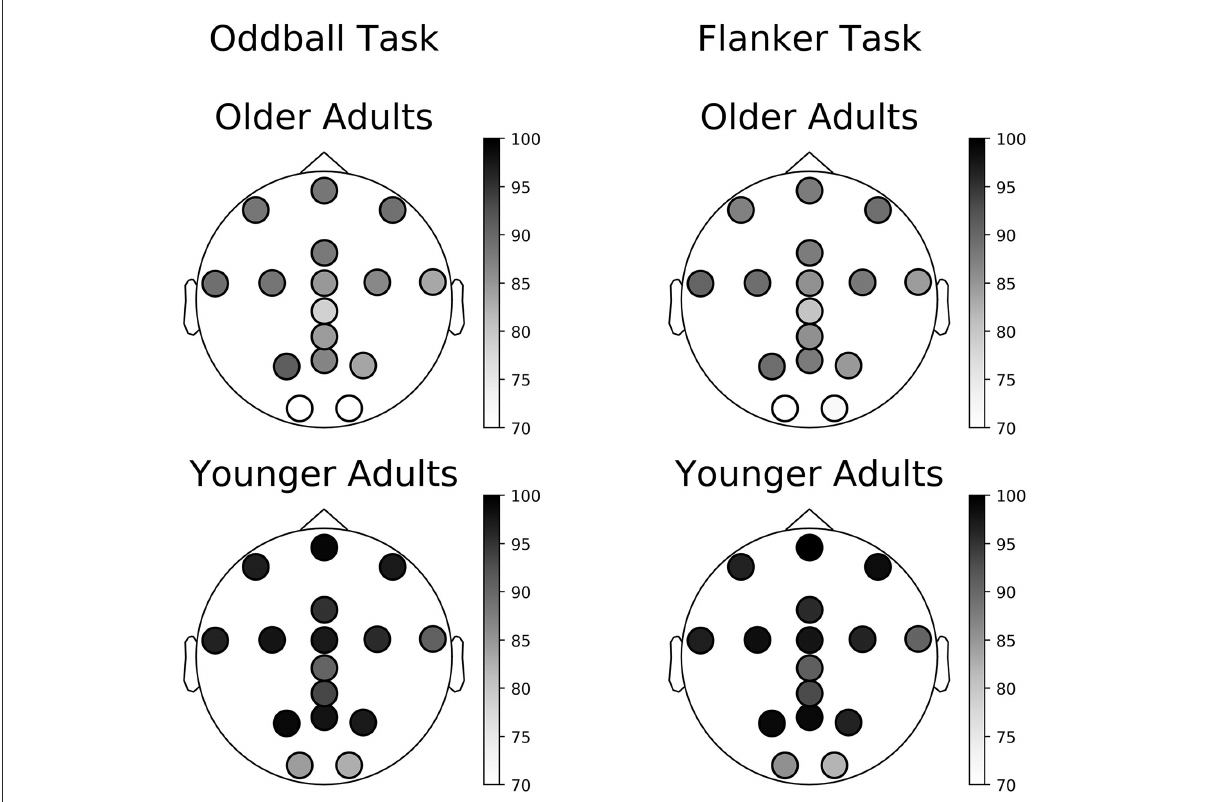
FIGURE6 Percentage of available sessions after pre-processing per channel. The top row corresponds to data collected in the Older Adult study. The bottom row corresponds to data collected during the Younger Adult study. The left column of each figure corresponds to data collected during the gamified Oddball task, the right column of each quadrant to data collected during the gamified Flanker